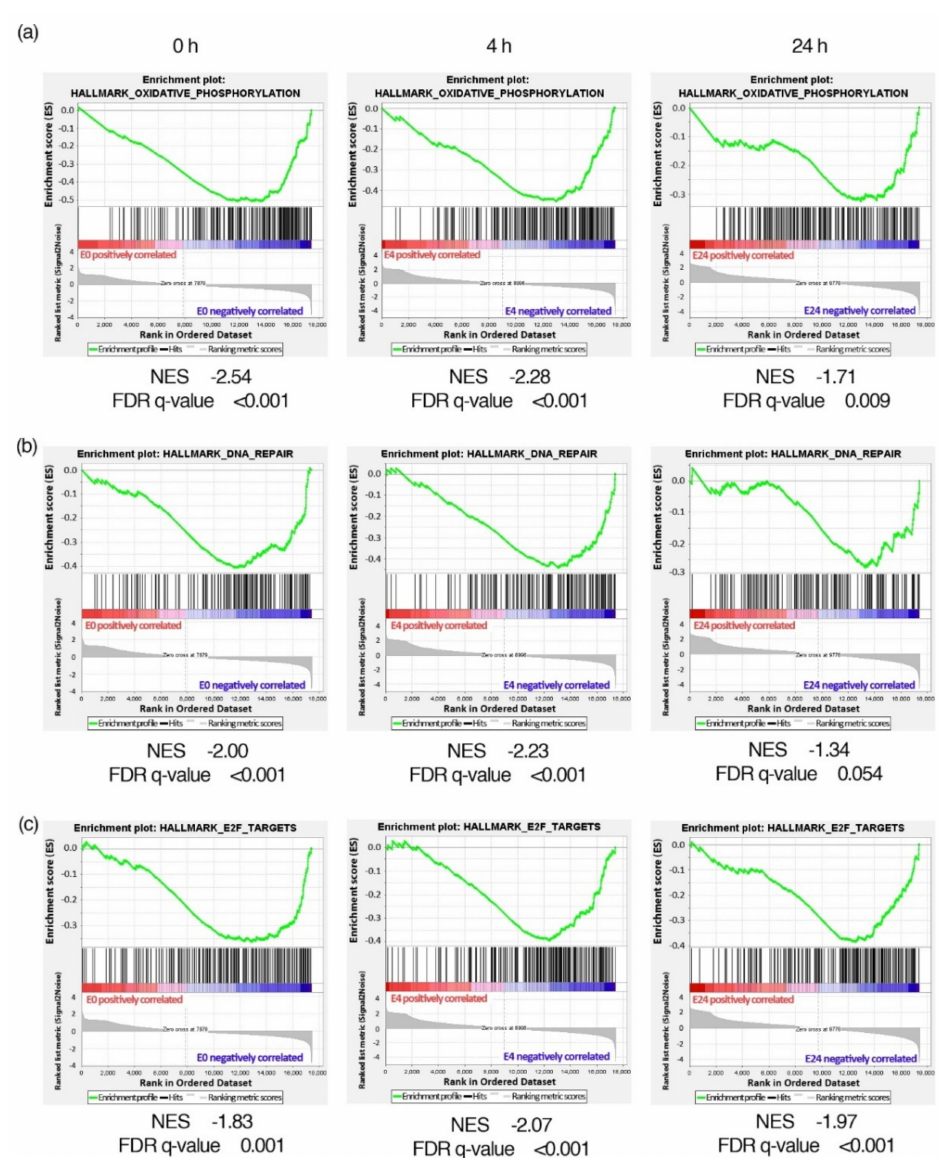
Figure 8. Gene set enrichment analysis for TM3 cells. E0: nsPEF-exposed cells, time 0 h; E4: nsPEF-exposed cells, time 4 h; E24: nsPEF-exposed cells, time 24 h. The most negatively enriched hallmark gene sets identified in the gene set enrichment analysis comparing nsPEF-exposed and sham samples at 0 h (left), 4 h (centre), and 24 h (right) time points. Normalised enrichment scores (NES) and false discovery rate (FDR) q-values are shown below the plots. ( a ) Hallmark: oxidative phosphorylation; genes encoding proteins involved in oxidative phosphorylation. ( b ) Hallmark: DNA repair; genes involved in DNA repair. ( c ) Hallmark: E2F targets; genes encoding cell-cycle-related targets of E2F transcription